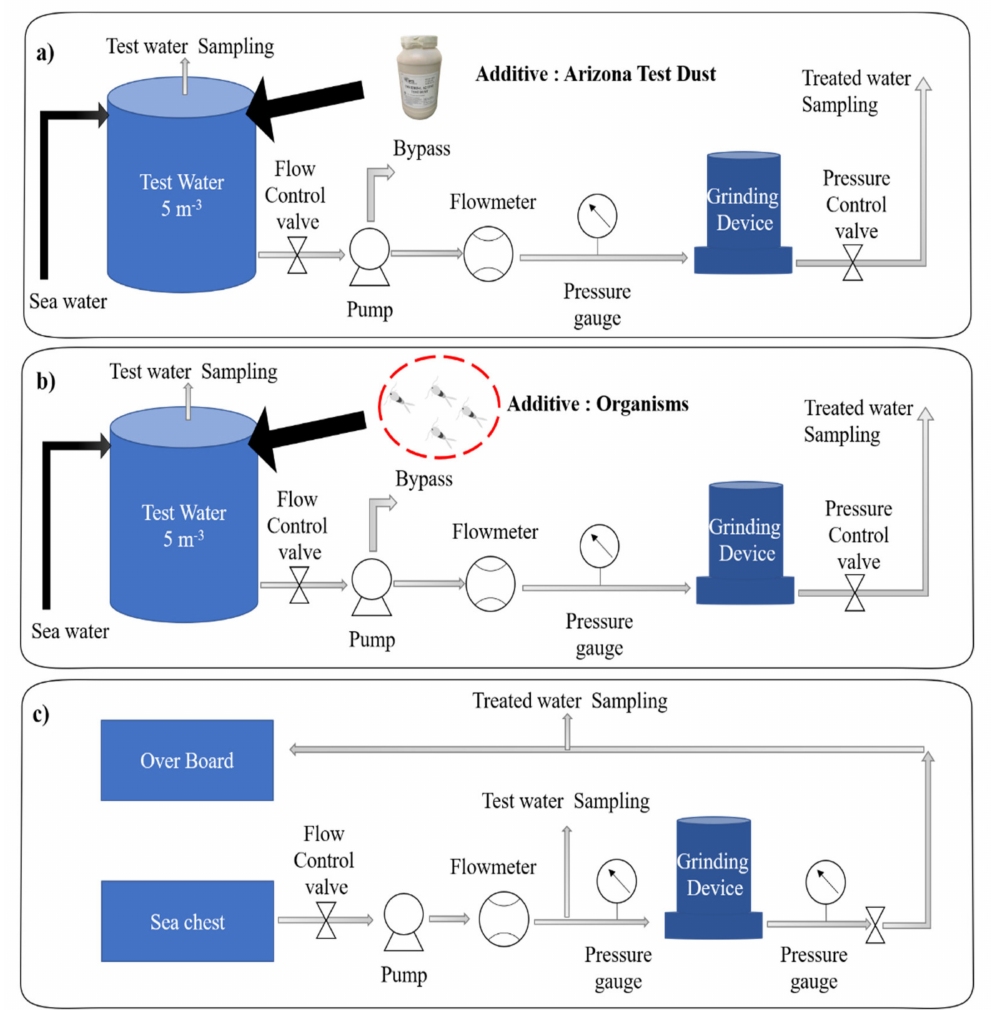
Figure 2. Schematic diagram of ( a ) evaluation of solid grinding efficiency, ( b ) pilot test and ( c ) full- scale test for grinding